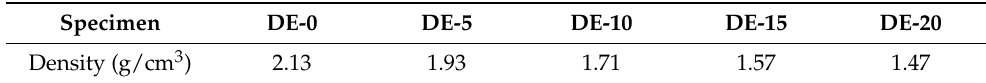
Figure 2. Schematic diagram of adding diatomite to cement soil. Table 4. Specimen density table.